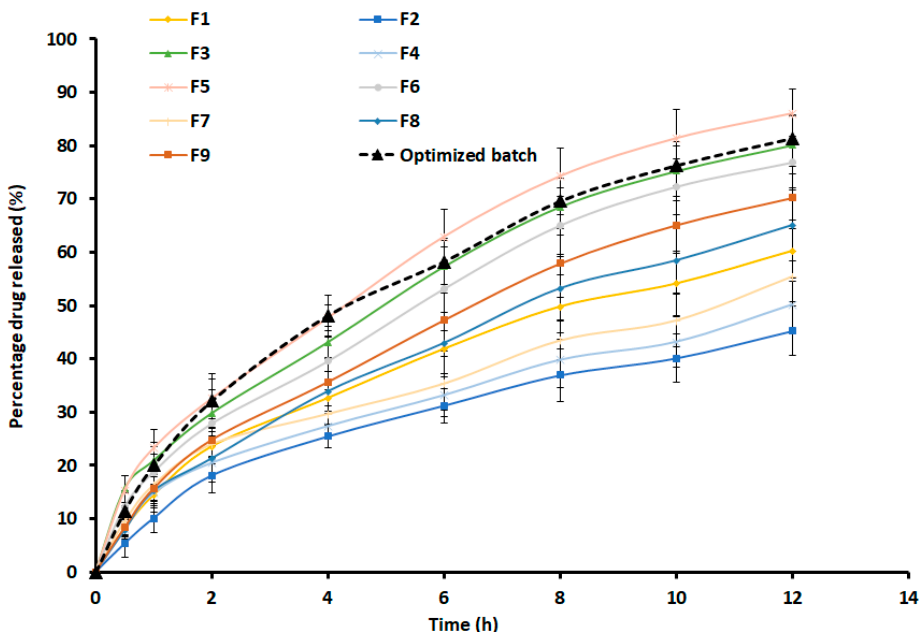
Figure 3. Release of treprostinil from design batches (F1–F9) and optimized transdermal patch (n = 6).